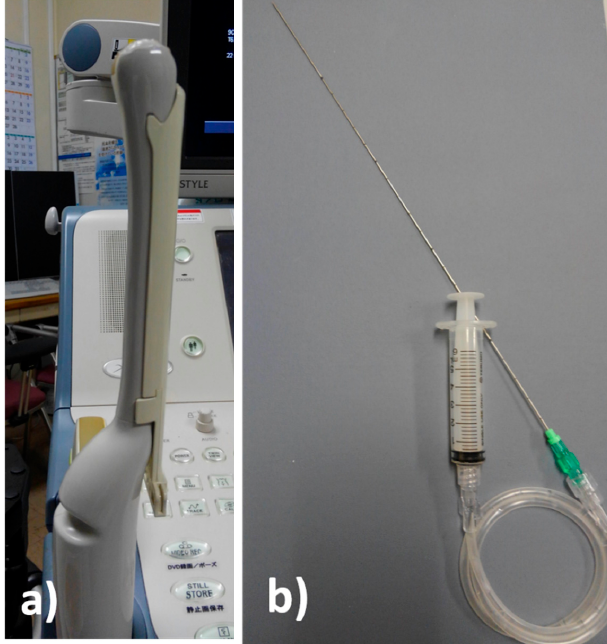
Figure 2. The preparation for transoral pharyngeal ultrasonography (TOPU). ( a ) The 6-MHz transvaginal probe with biopsy adaptor (UAGV-024A, Canon Medical Co., Tochigi, Japan). ( b ) The custom-ordered 21-gauge, 25-cm needle with syringe and extension tube.